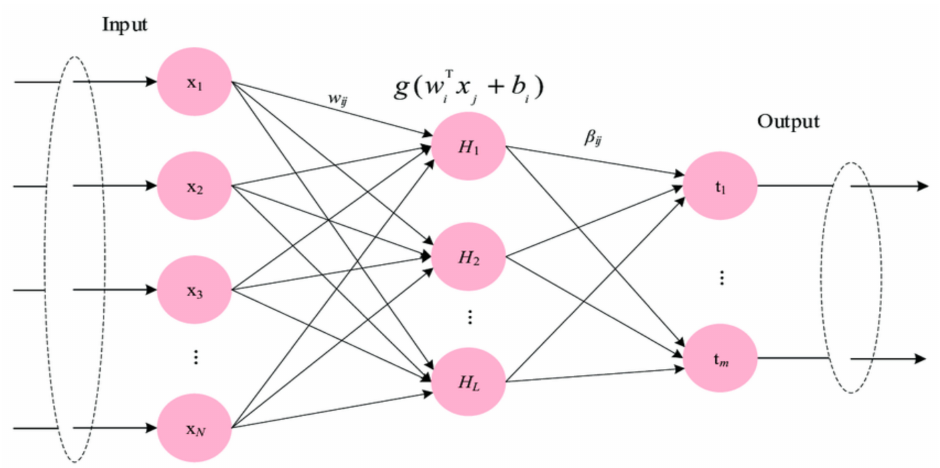
Figure 4. Basic structure of single-layer feedforward neural network (SLFN)